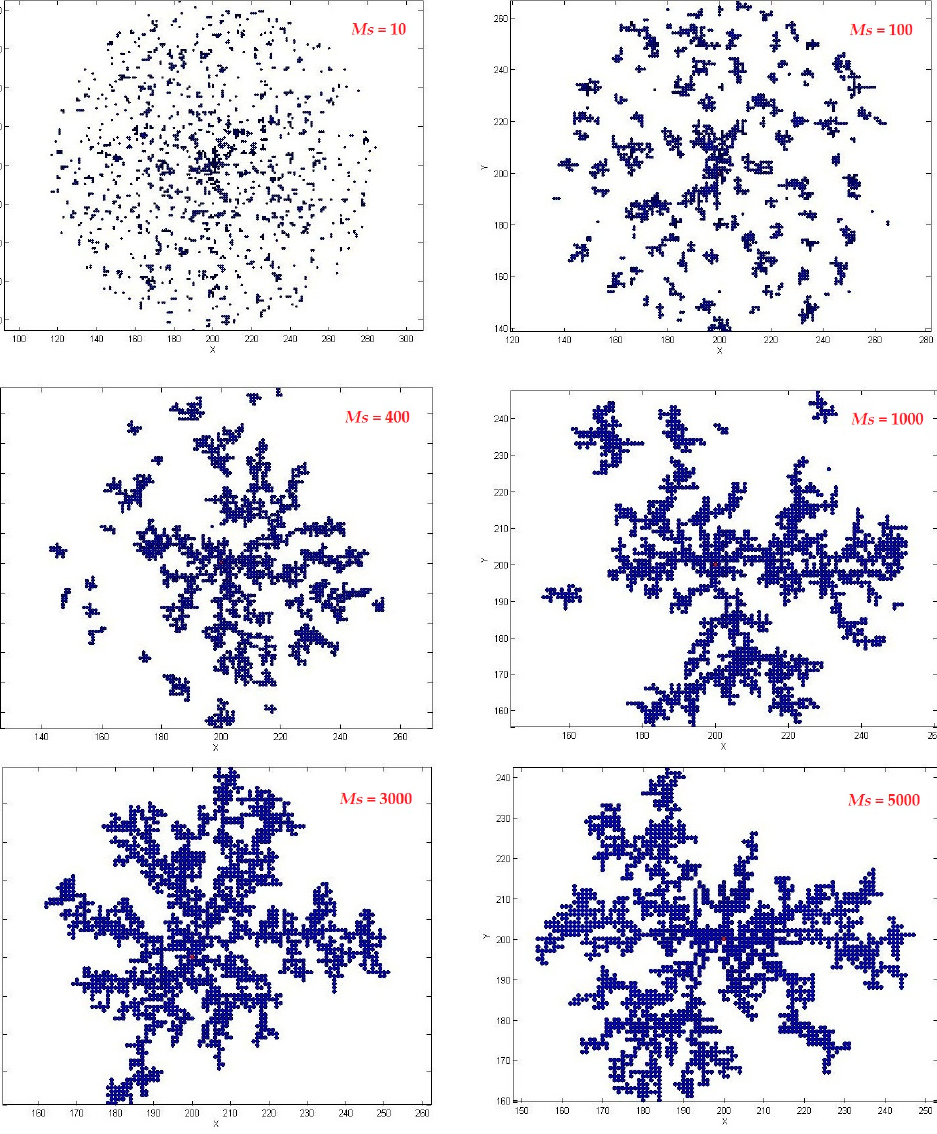
Figure 11. 2D DLA aggregates with diverse finite motion step numbers.